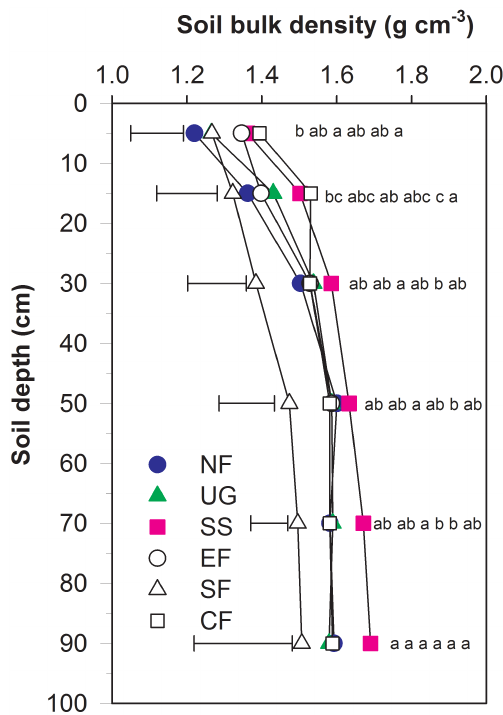
Figure 2. Changes in soil bulk density along soil profile under dif- ferent land uses types (NF, native forest; UG, unused grassland; SS, secondary shrub; EF, eucalyptus forest; SF, sugarcane field; CF, corn field). Error bars represent LSD calculated by one-way ANOVA at P = 0.05 level ( N = 5), and different lowercase let- ters indicate significant changes between land-use types within soil depth (Note: letters from left to right stand for NF, UG, SS, EF, SF and CF,